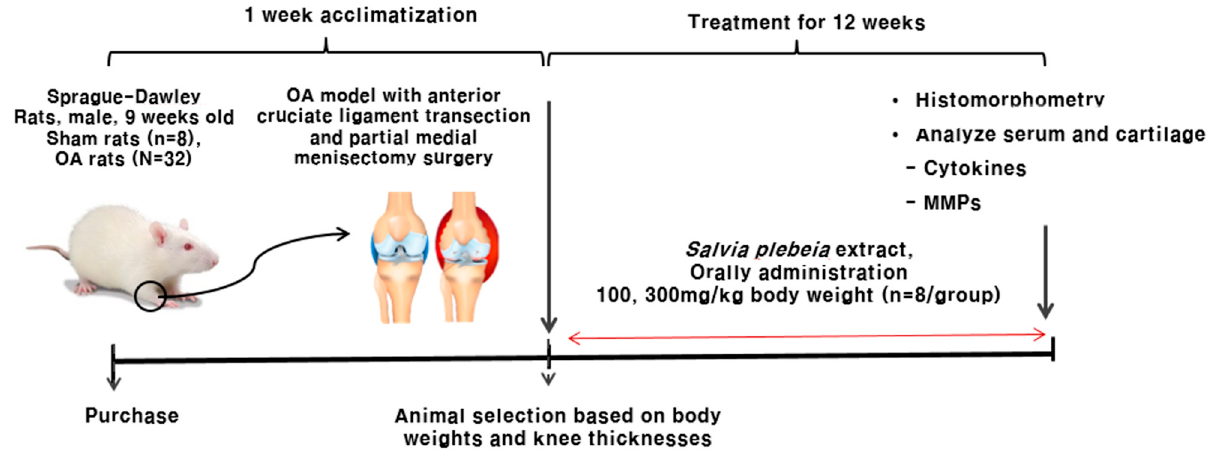
Figure 1. Experimental design for the animal study.